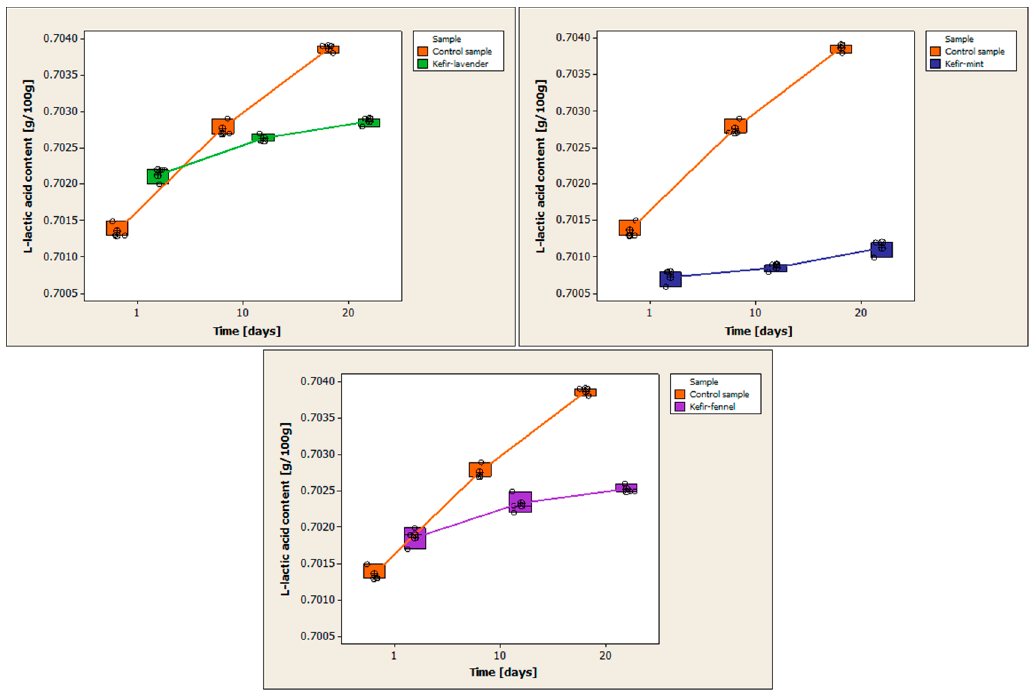
Figure 9. Comparative variation of L-lactic acid content determined by the enzymatic method in kefir samples with encapsulated volatile oils and the control sample.